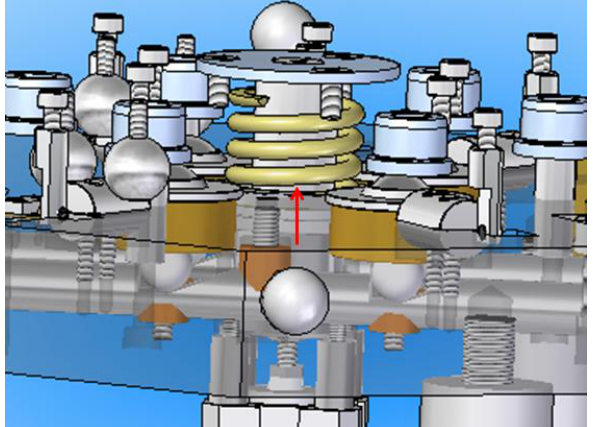
Figure 13. Preload spring used in the Indexed Metrology